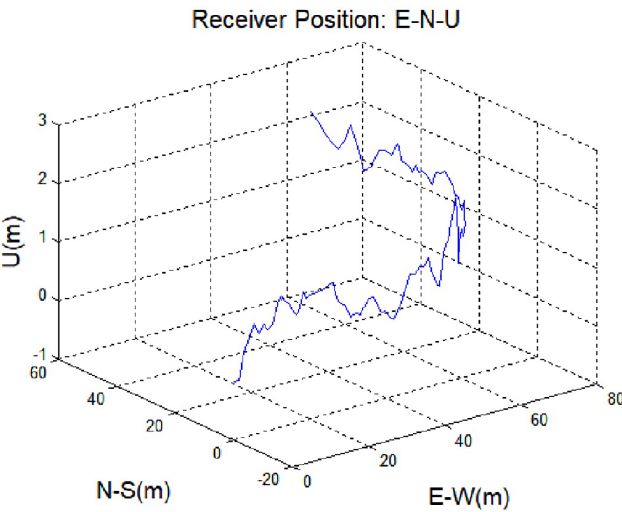
Fig 7. Receiver position during a spoofing attack with all channels subject to a 1.465-m pseudorange delay.